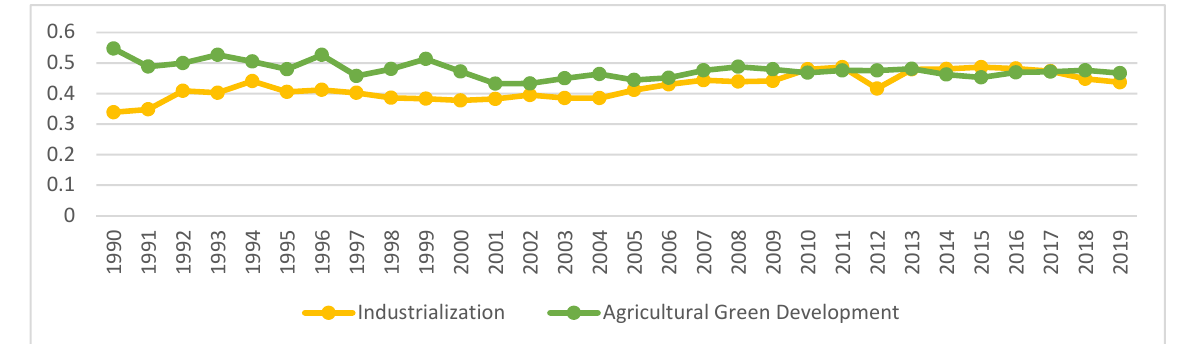
Figure 2. China’s industrialization and agricultural green development level 1990–2019. Data Source: The author calculated based on China Statistical Yearbook, China Industrial Statistical Yearbook, China Rural Statistical Yearbook, China Regional Economic Statistical Yearbook.